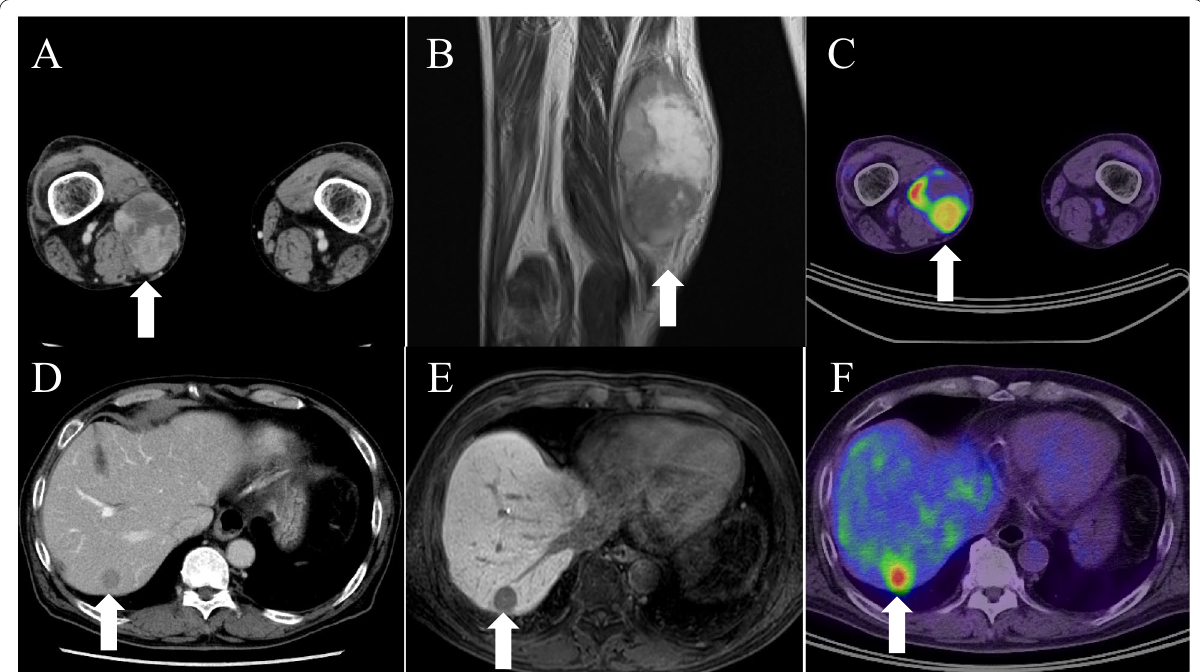
Fig. 1 A Contrast-enhanced computed tomography (CT) revealing a mass with a heterogeneous contrast effect in the right thigh. B T2-weighted magnetic resonance imaging (MRI) showing a solid tumor with high intensity in the right medial thigh, which is suggestive